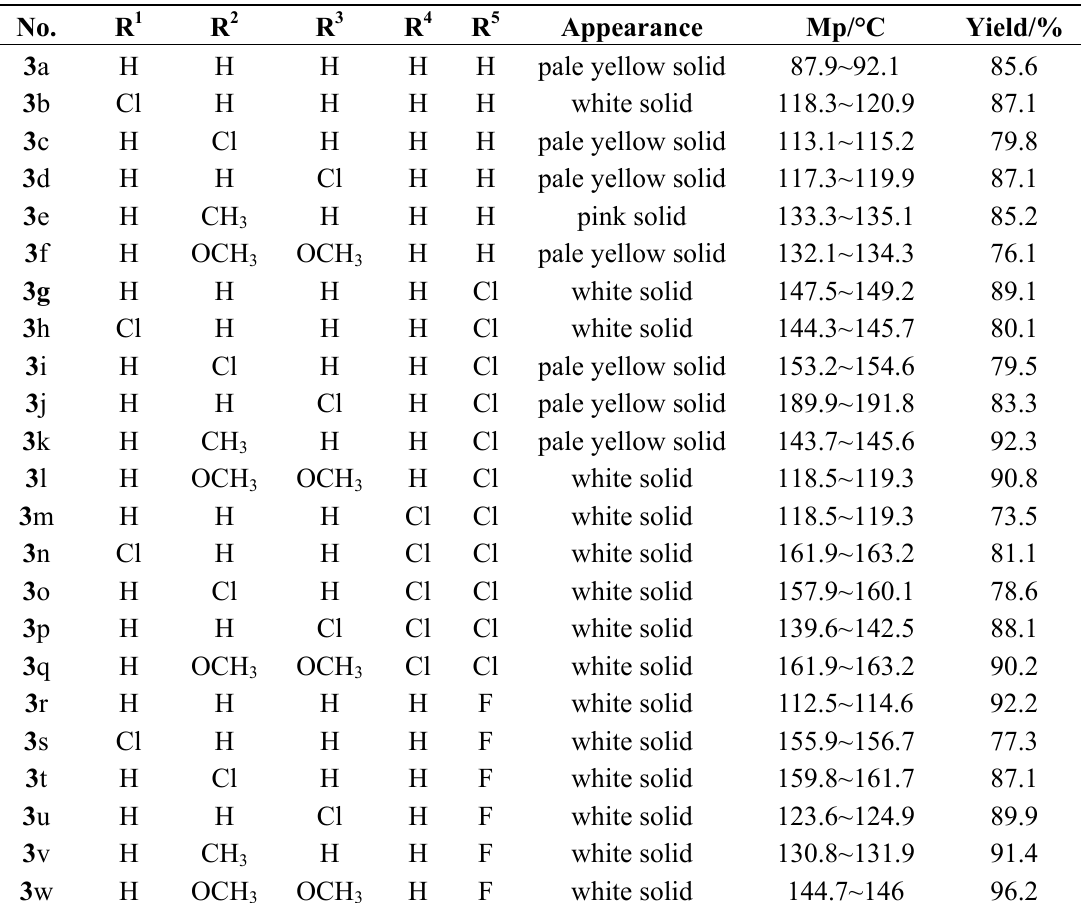
Table 4. Molecular structures, yields, and melting points of synthesized 2-phenoxy-4 H - 3,1-benzoxazin-4-ones 3